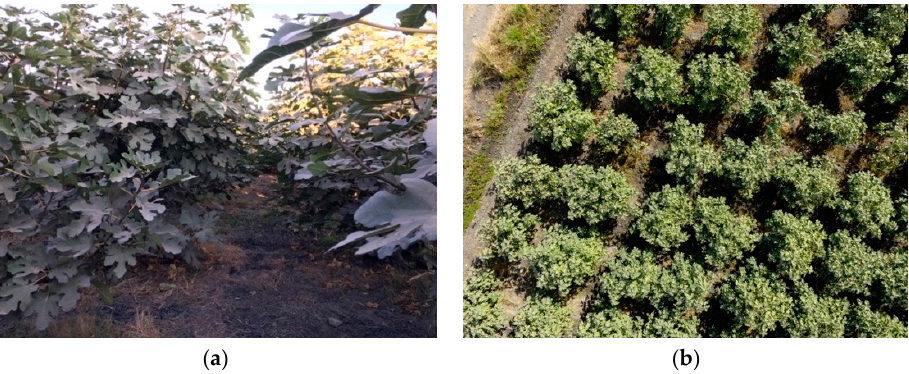
Figure 1. ( a ) Ground view and ( b ) top-view of fig shrubs.